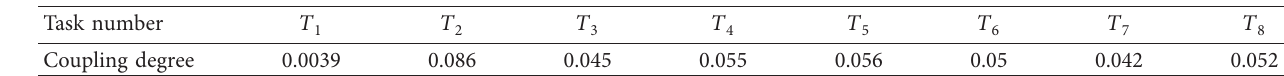
Table 2: Coupling degree of each task.